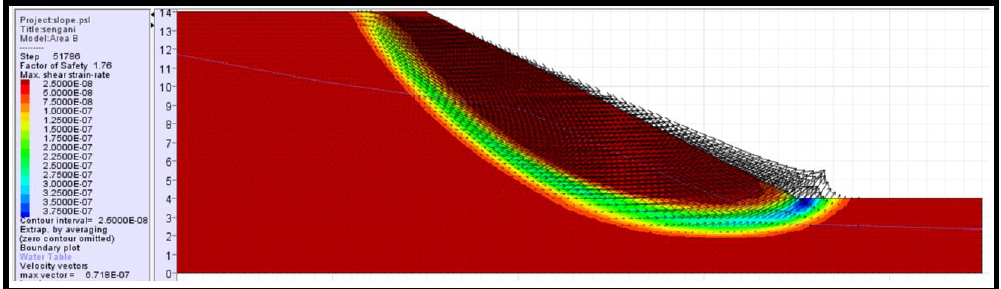
Figure 24. Simulated FoS of the silt clay soil slope using FLACSlope in rainy conditions with a water table with 1500 m 3 volume of water. Note that maximum shear strain simulated ranges between 2.500 × 10 −8 to 6.718 × 10 −7 . Appl. Sci. 2020 , 10 , x FOR PEER REVIEW